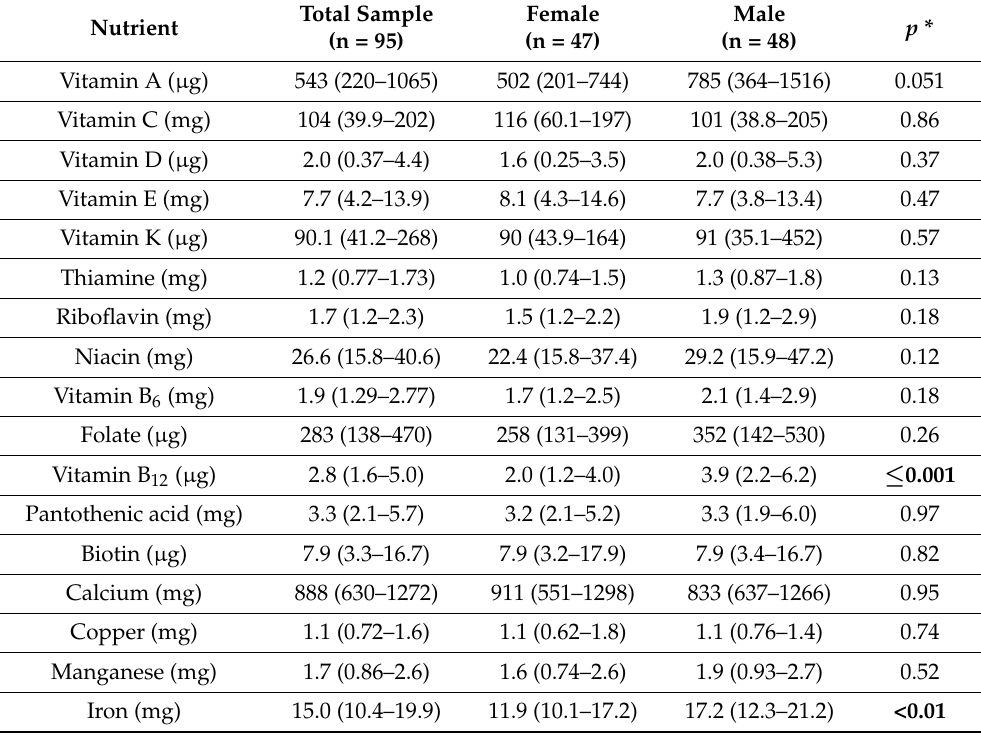
Table 3. Dietary micronutrient intakes of female and male endurance